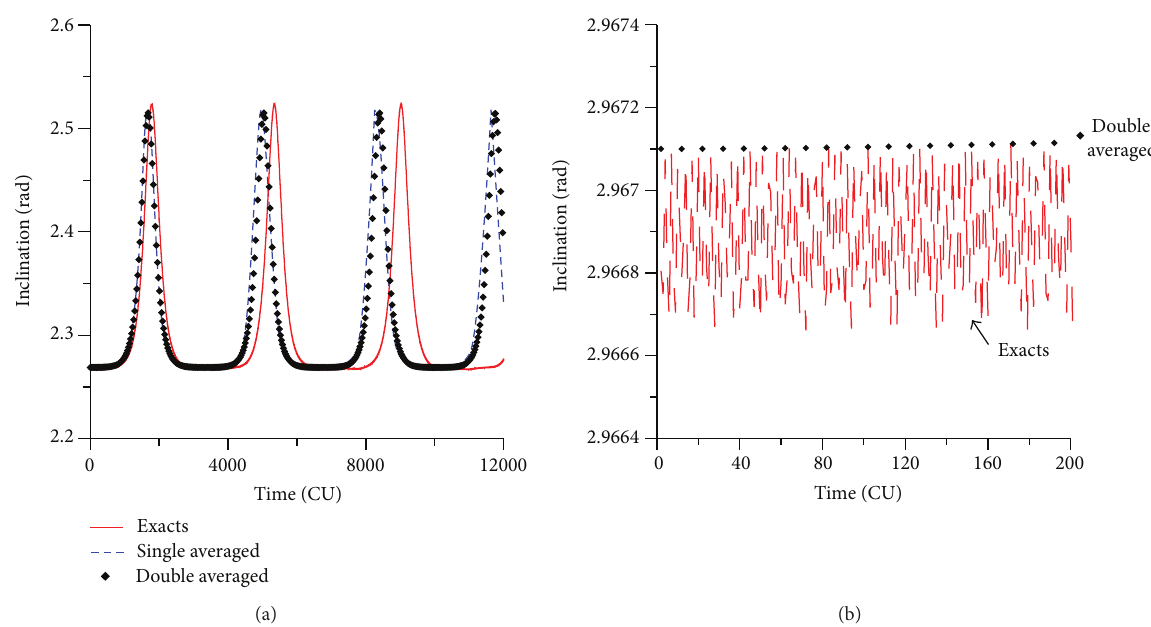
Figure 5: Evolution of the inclination for values of the inclination of 130 ∘ and 170 ∘ . Initial conditions are a = 0.341 canonical units, e (0) = 0.01, M 0 (0) = 0, 𝜔 (0) = 0, and Ω (0) = 0. The results for the single and double averaged models are the